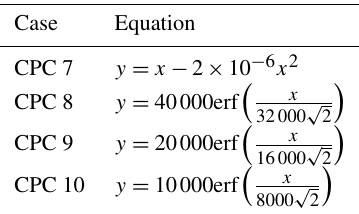
Table 4. Equations used to model the relationship between a refer- ence or true aerosol concentration x (particlescm − 3 ) and the con- centration measured by a condensation particle counter y (parti- clescm − 3